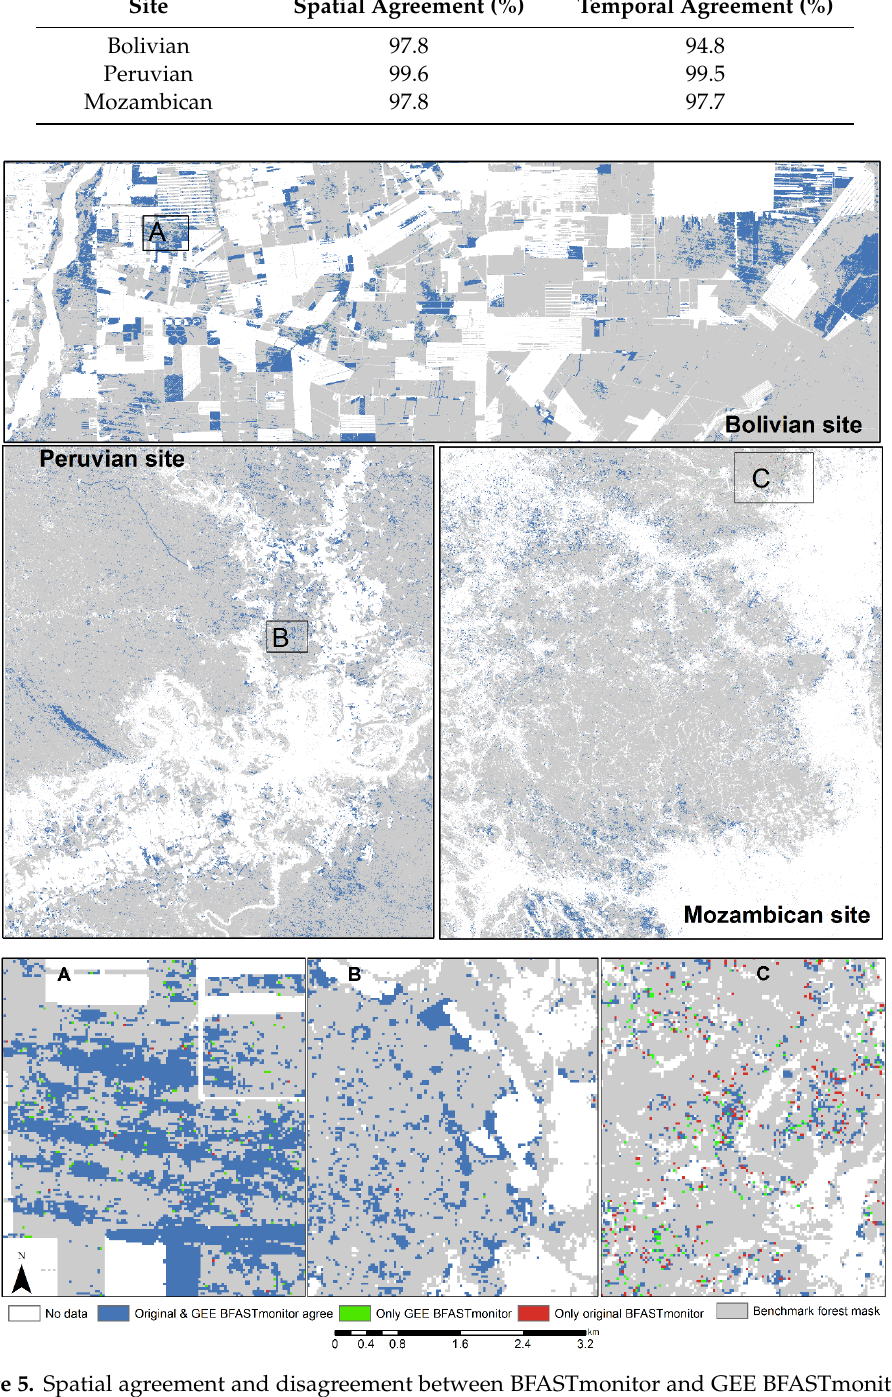
Figure 5. Spatial agreement and disagreement between BFASTmonitor and GEE BFASTmonitor on forest disturbance in the Landsat NDMI time series at ( A ) dry (Bolivian site) and ( B ) humid (Peruvian site) tropical forest and ( C ) Miombo woodland (Mozambican site).